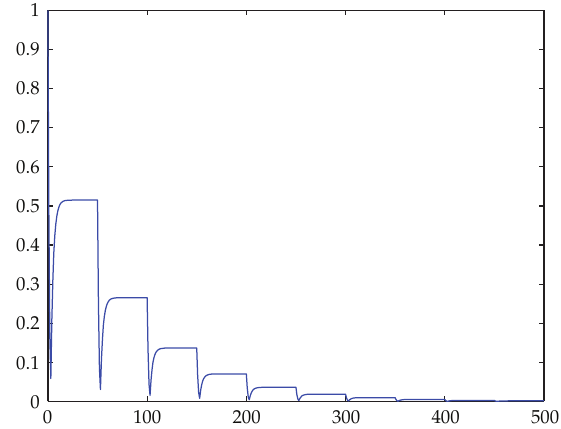
Figure 4: The Radau IIA collocation method with m (cid:4) 3 and p (cid:4) 1000 for (cid:2) 7.1 (cid:3)